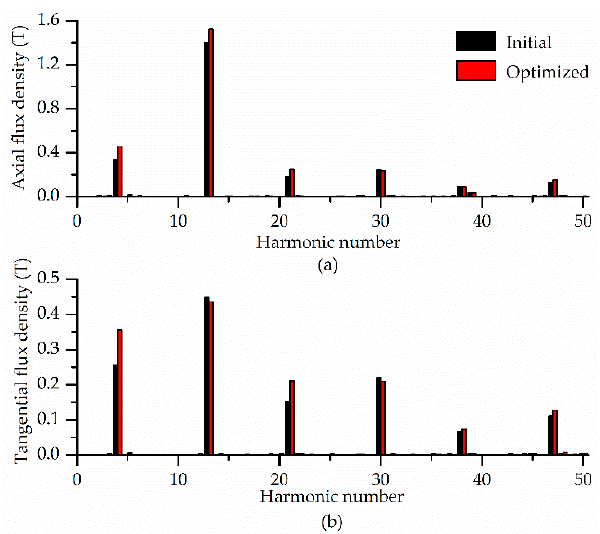
Figure 12. FFT analysis of the axial and tangential flux densities at the radius of R m2 in the LG of the HAMG. ( a ) Axial flux density; ( b ) Tangential flux density.